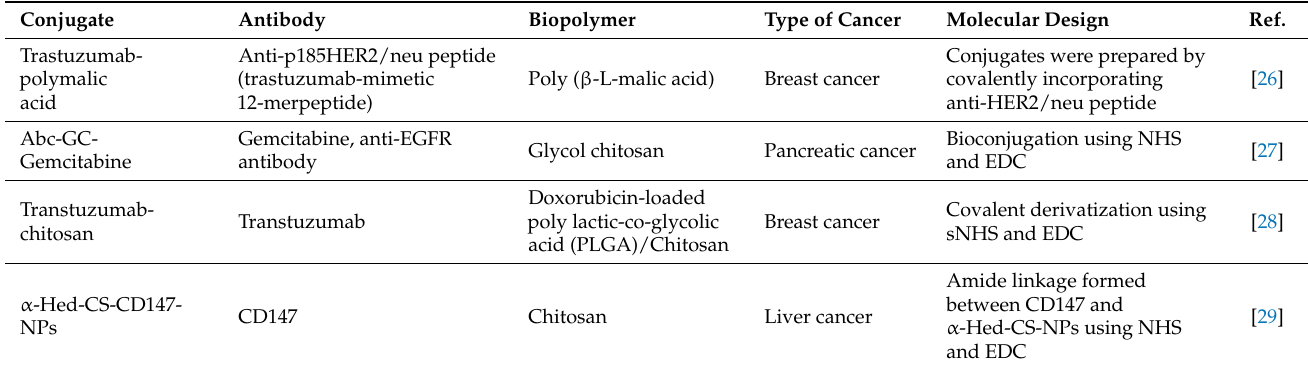
Table 1. Summary of the efficacy of several antibody–biopolymer conjugates on